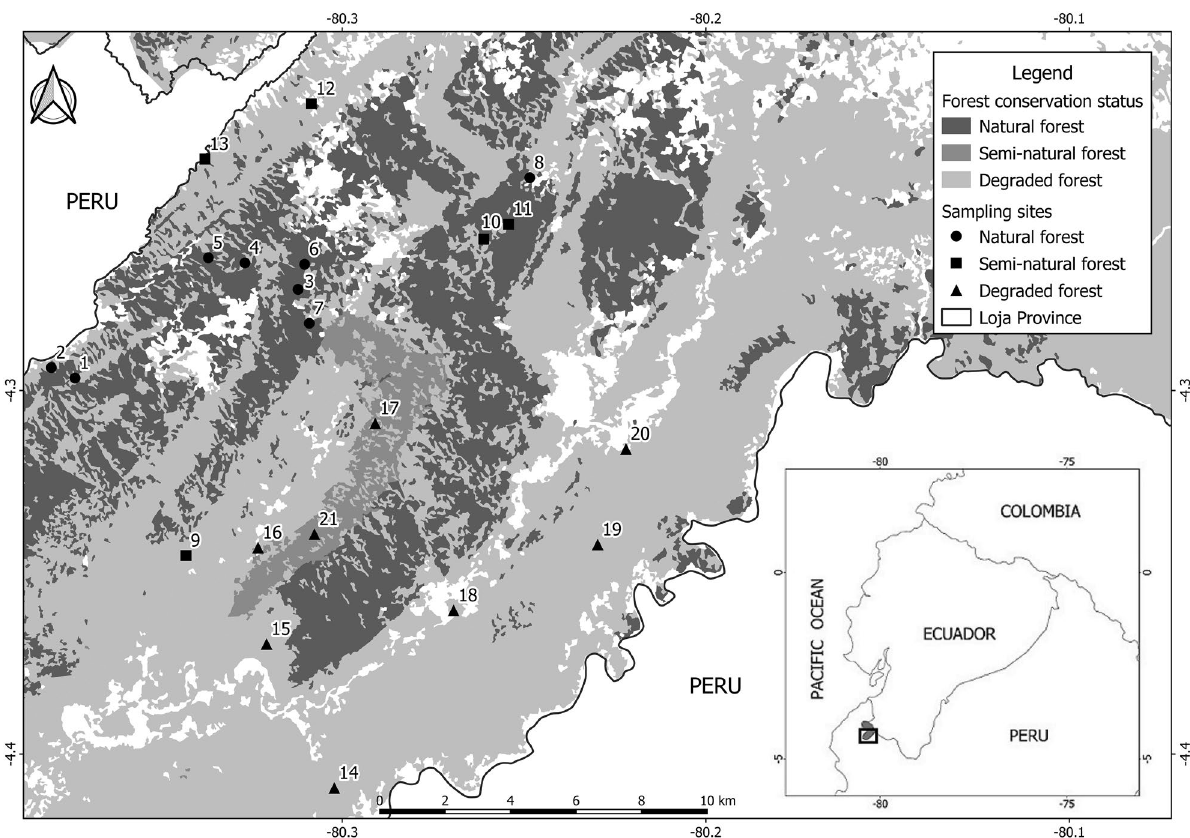
Figure 6. Study area and location of sampling sites. Numbers correspond to sites listed in Supplementary Table S1. The underlying map was constructed using QGIS version 2.14.20 (https